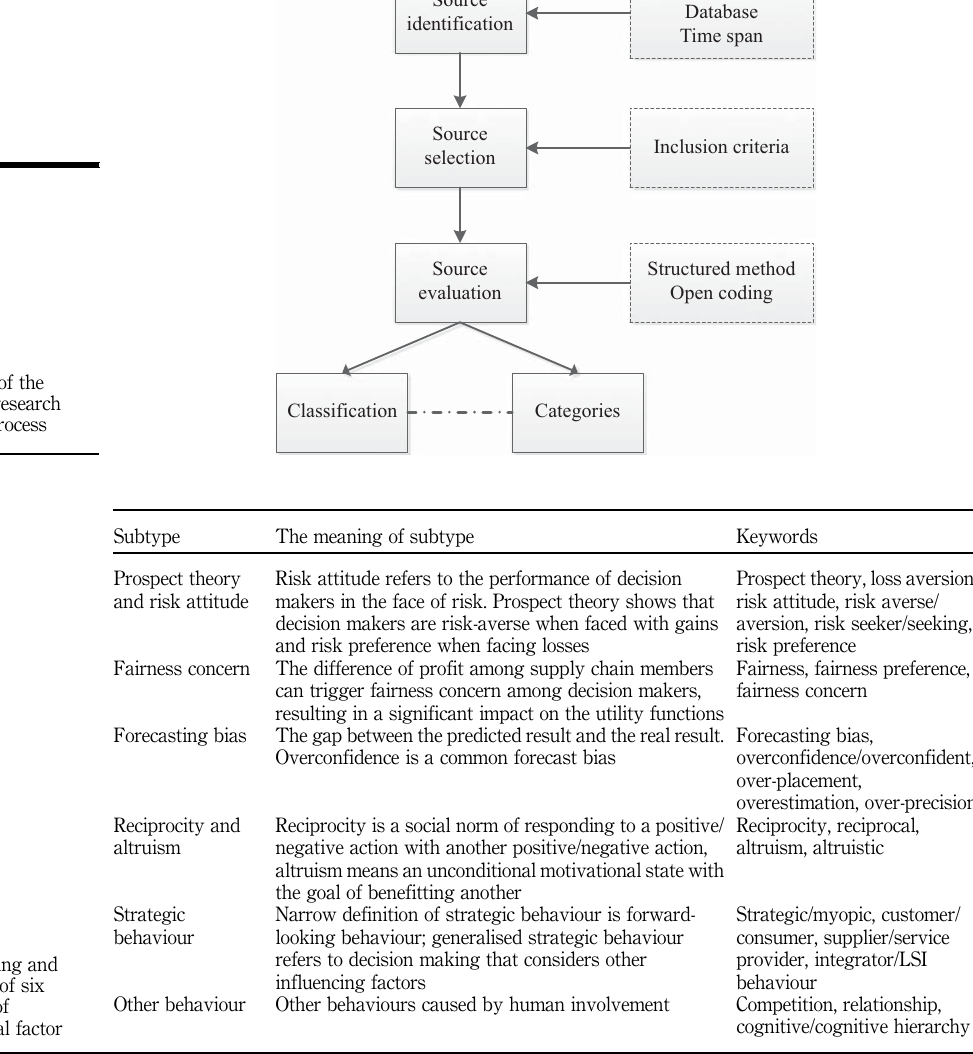
keywords of six subtypes of behavioural